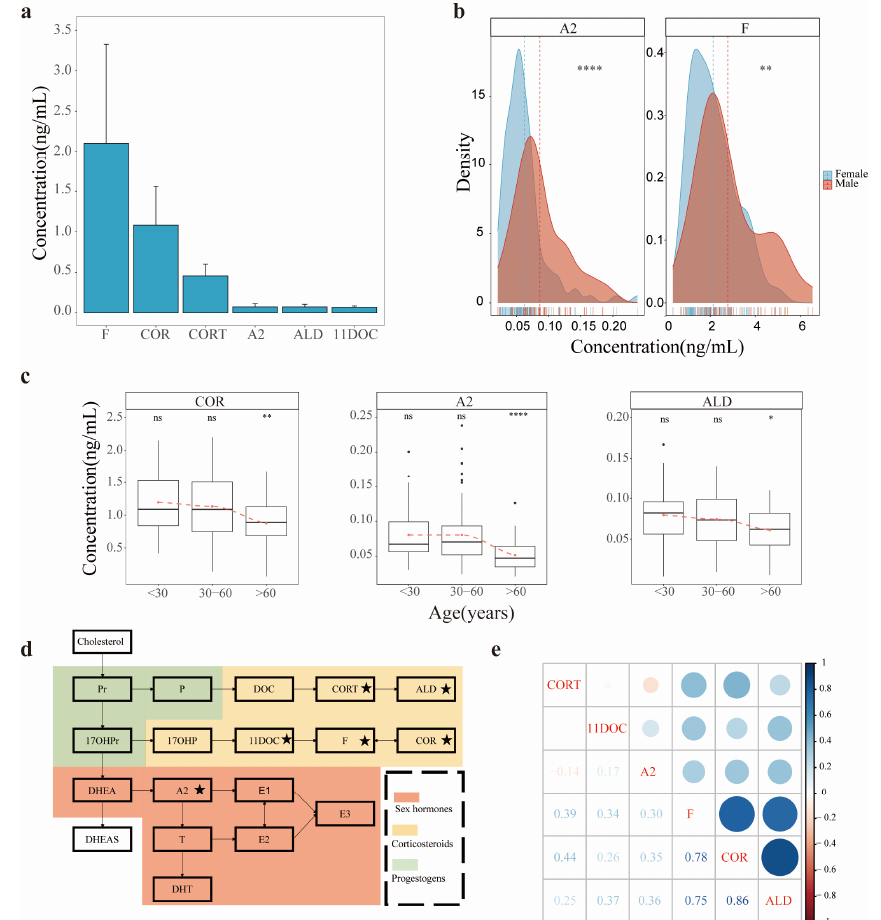
Figure 2. Profile of steroid hormones in AH. ( a ) The abundance distribution of steroid hormones in AH in this study. ( b ) Comparison of the A2 and F abundance distribution between male and female AH in the cohort this study. (** represents the p value < 0.01, and **** represents the p value < 0.0001). ( c ) The age-dependent potential of the 3 AH steroid hormones COR, A2 and ALD (* represents a p value < 0.05; ** represents a p value < 0.01, and **** represents a p value < 0.0001). ( d ) The metabolic pathways of steroid hormones in humans (the stars represent the steroid hormones detected in AH in this study). ( e ) The abundance correlations for all of the AH steroid hormones (Spearman’s correlation, the values represent Spearman’s correlation coefficients).